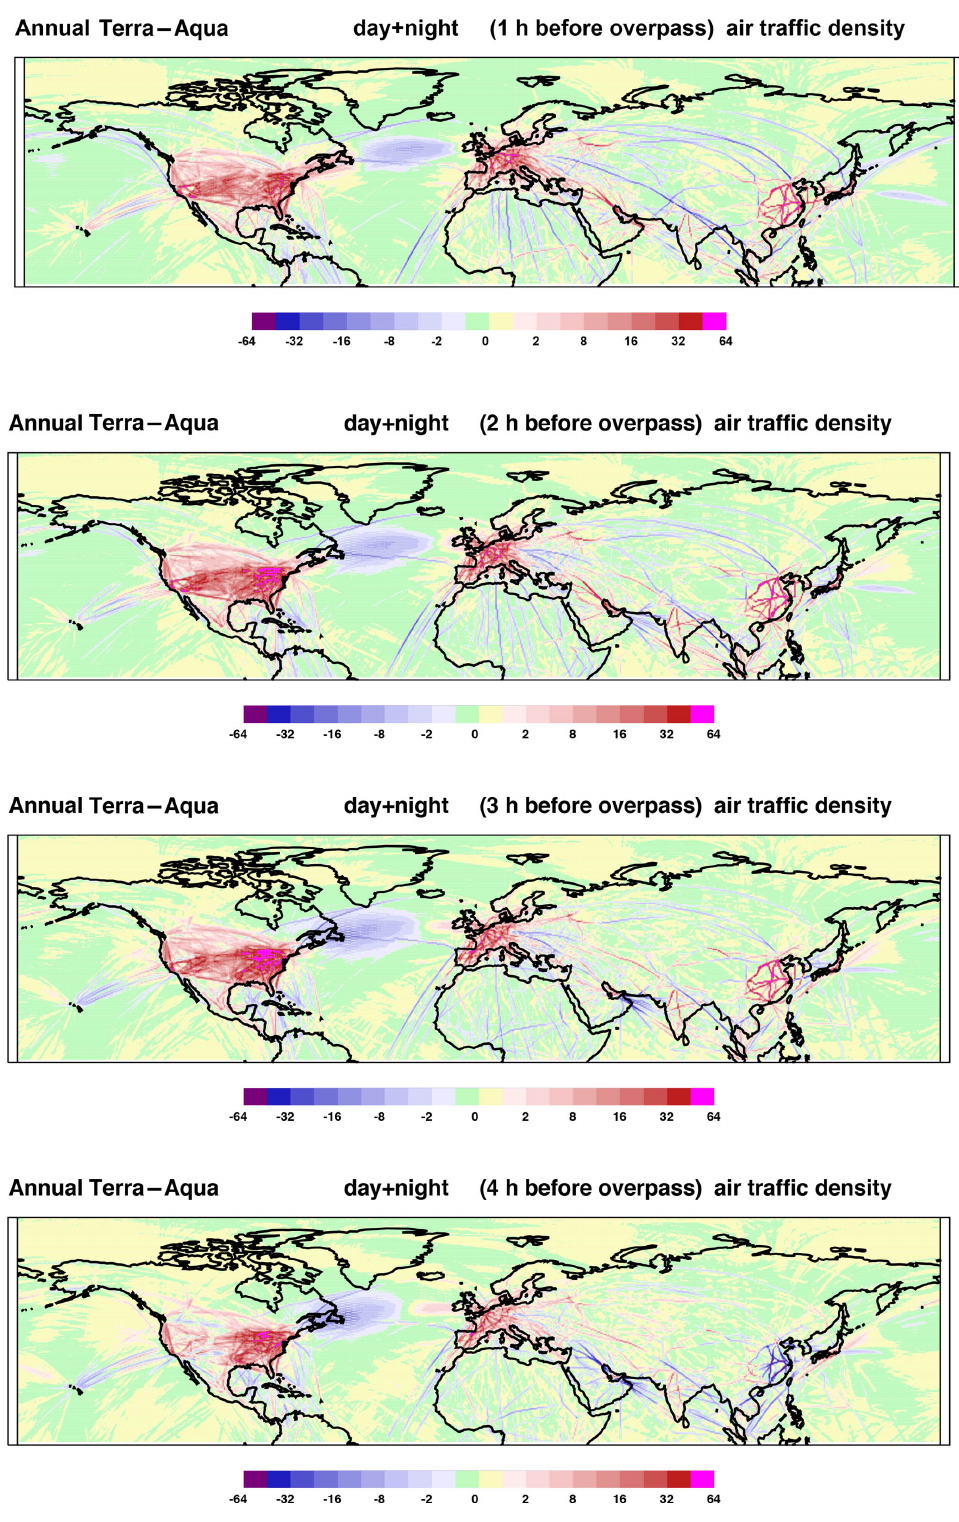
Figure 2. The difference in the 2012 annual-mean air traffic density (in flights above 7.62km per degree grid box per hour) relative to the Terra and Aqua MODIS overpass times, for 1h intervals from 1 to 4h before